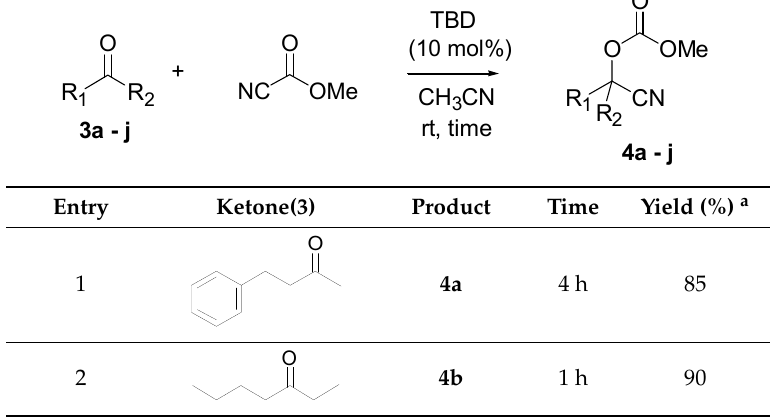
Table 2 TBD catalyzed cyanation of ketones with methyl cyanoformate.